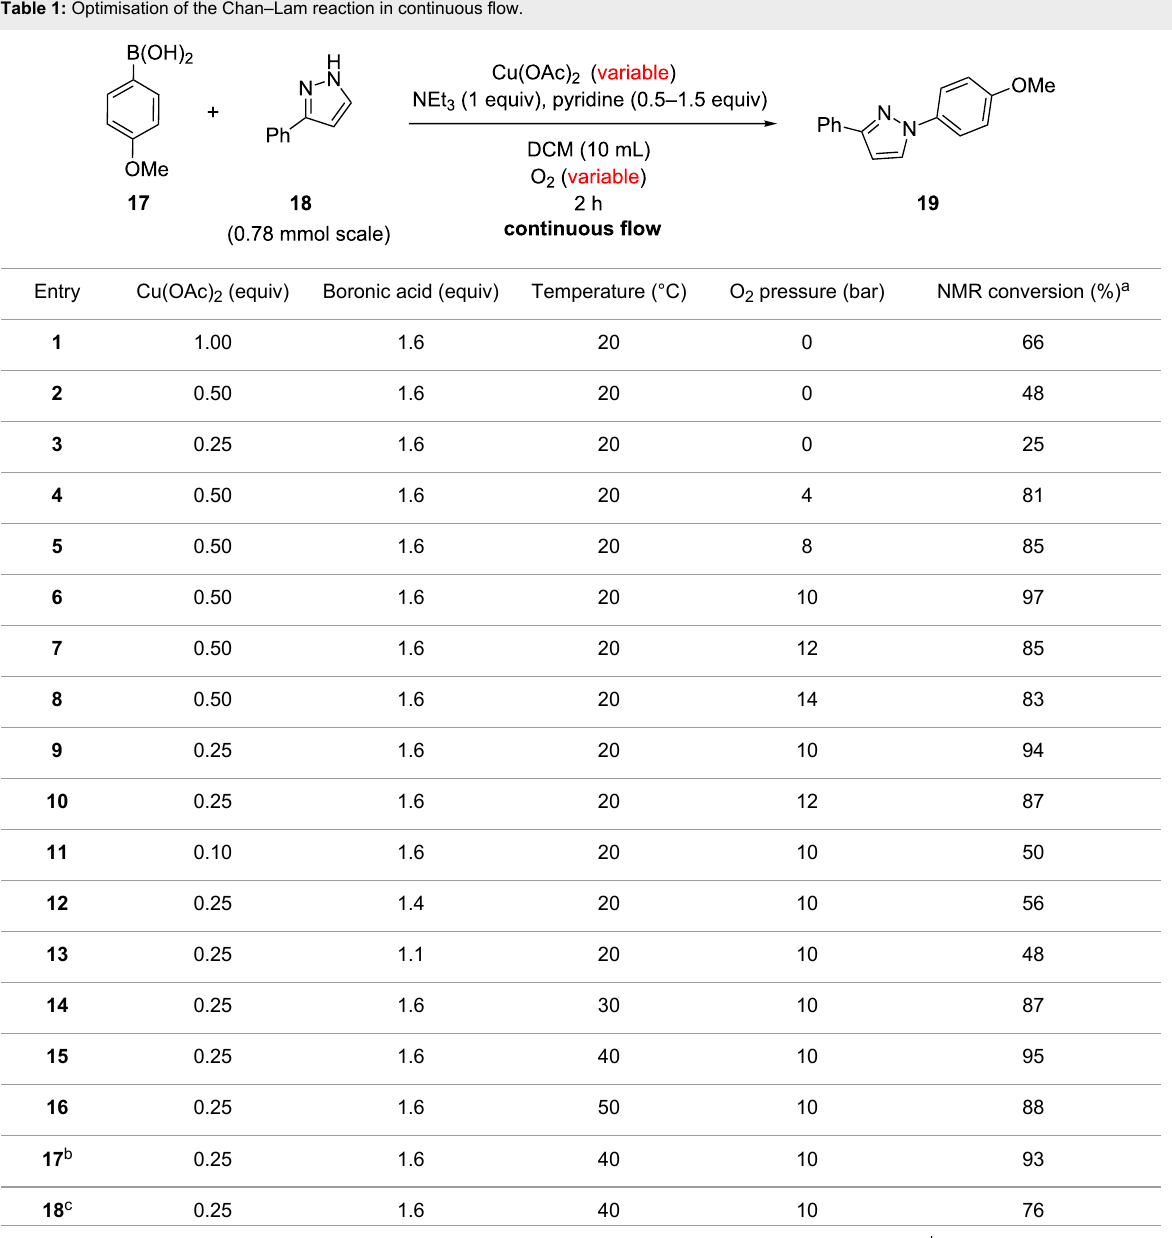
Table 1: Optimisation of the Chan–Lam reaction in continuous